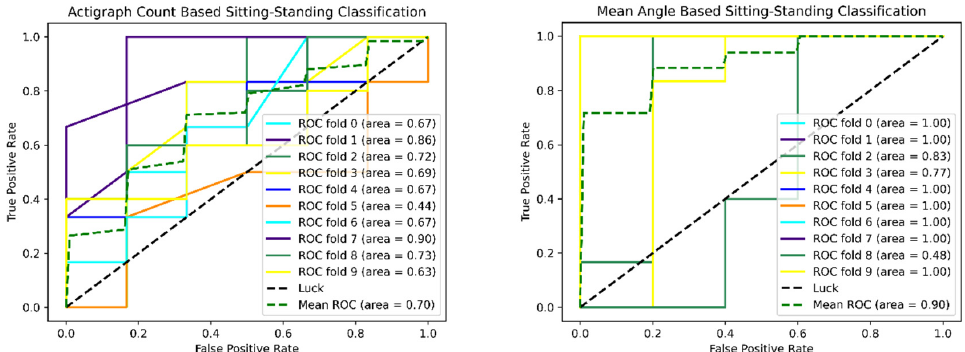
Figure 11. ROC curve for sitting and standing classification. The left panel denotes the ROC curve for the Actigraph count-based sitting and standing classification. The right panel denotes the mean angle-based static and dynamic activities’ classification.